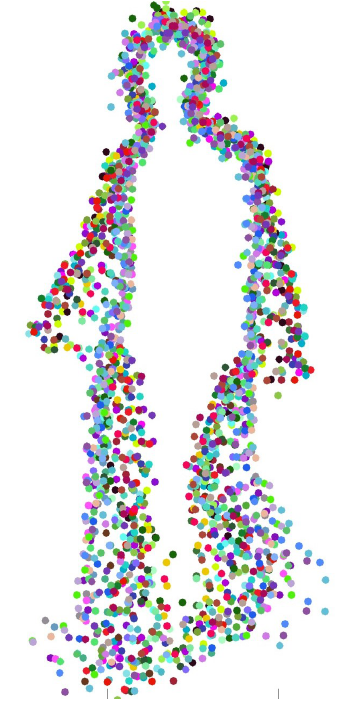
Figure 8. Representation of the aligned shapes of the training